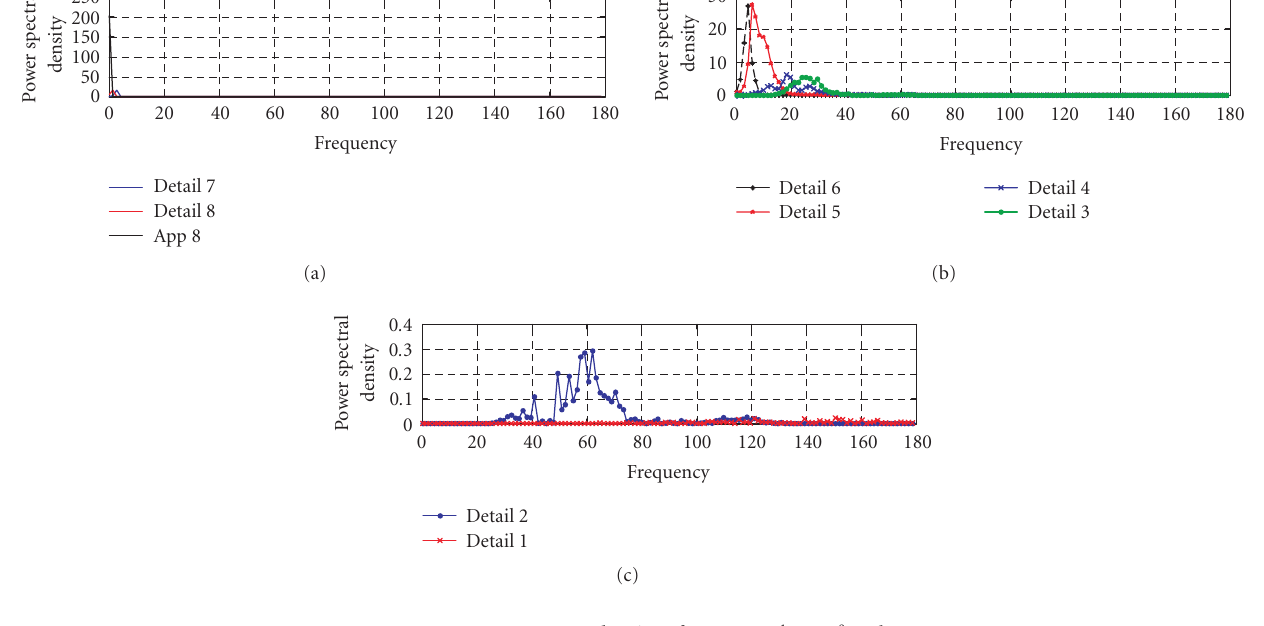
Figure 5: Power spectrum density of ECG at 2 − 1 to 2 − 8 scales.